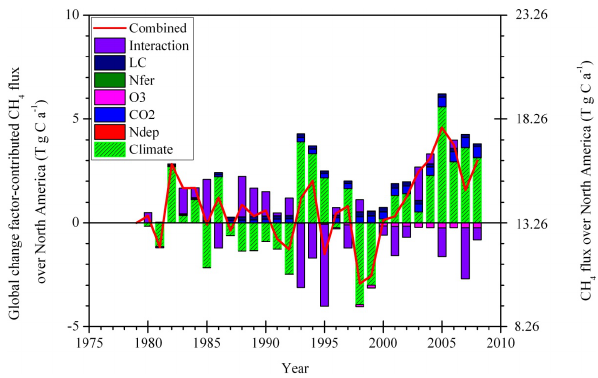
flux with baseline; 3 4 means contribution 5 3 ; Ndep means 6 2